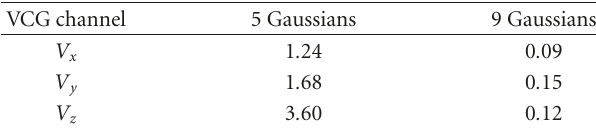
Table 2: The percentage of MSE in the synthetic VCG channels us- ing five and nine Gaussian functions.